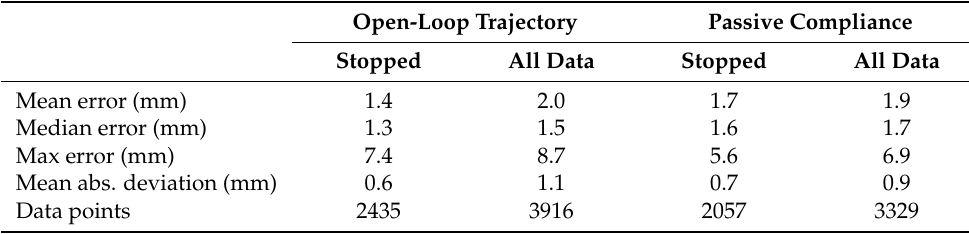
Table 1. Summary of sensor evaluation